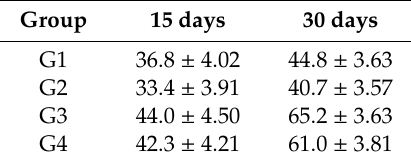
Table 1. Mean and standard deviation (SD) of removal torque values measured for each group in Ncm. Table 3. Table data (mean and standard deviation) of the removal torque values (RTv) measured of each sample.